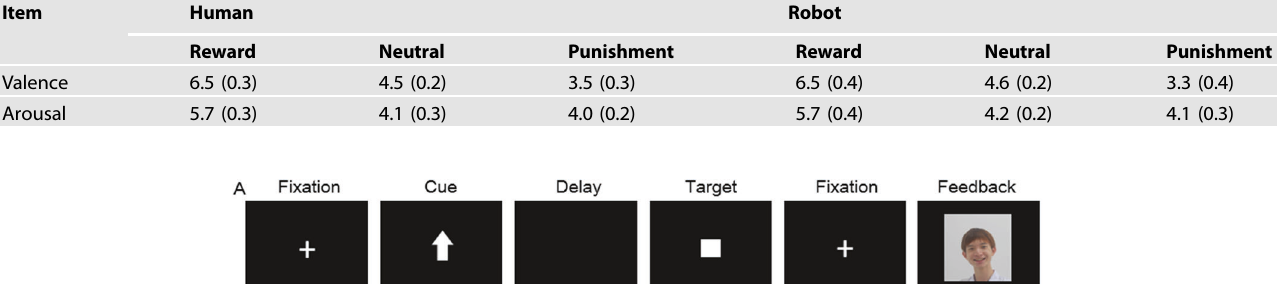
Table 2. Valence and arousal of pictures on a 1-to-9-point scale (mean and standard deviation).